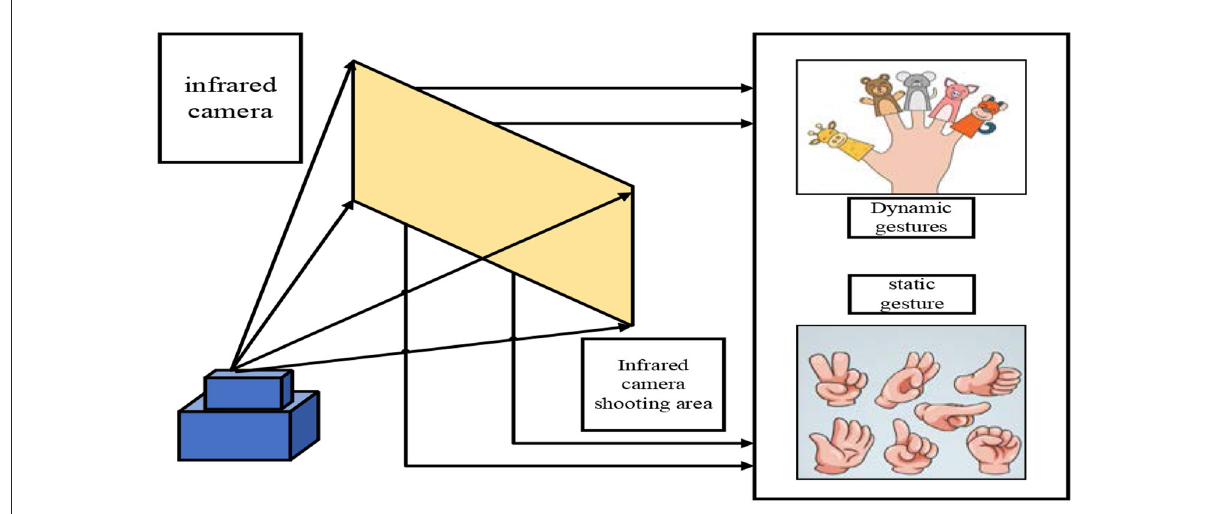
FIGURE3 Schematic diagram of the field of view of the infrared